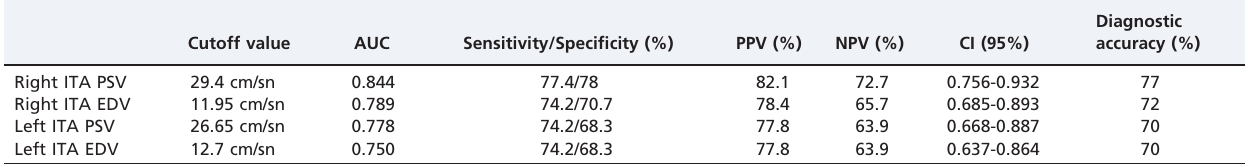
Table 3 - The most appropriate cutoff values for the right and left ITA-blood flow velocities for differentiating GTT from GD during